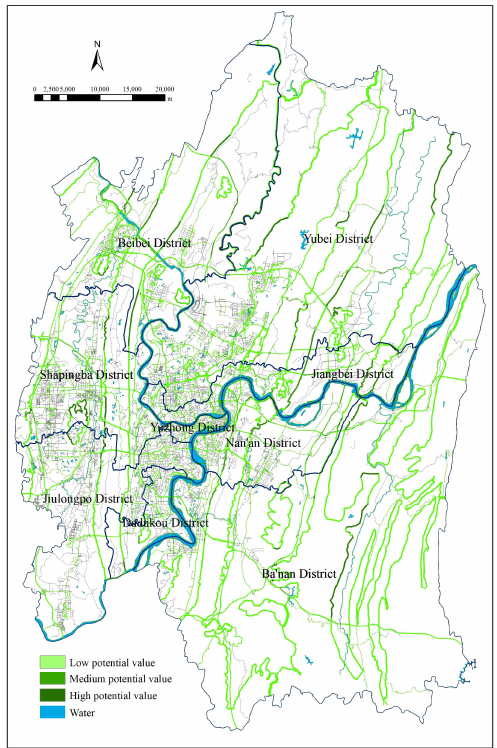
Figure 5. UGS potential map after buffer analysis.